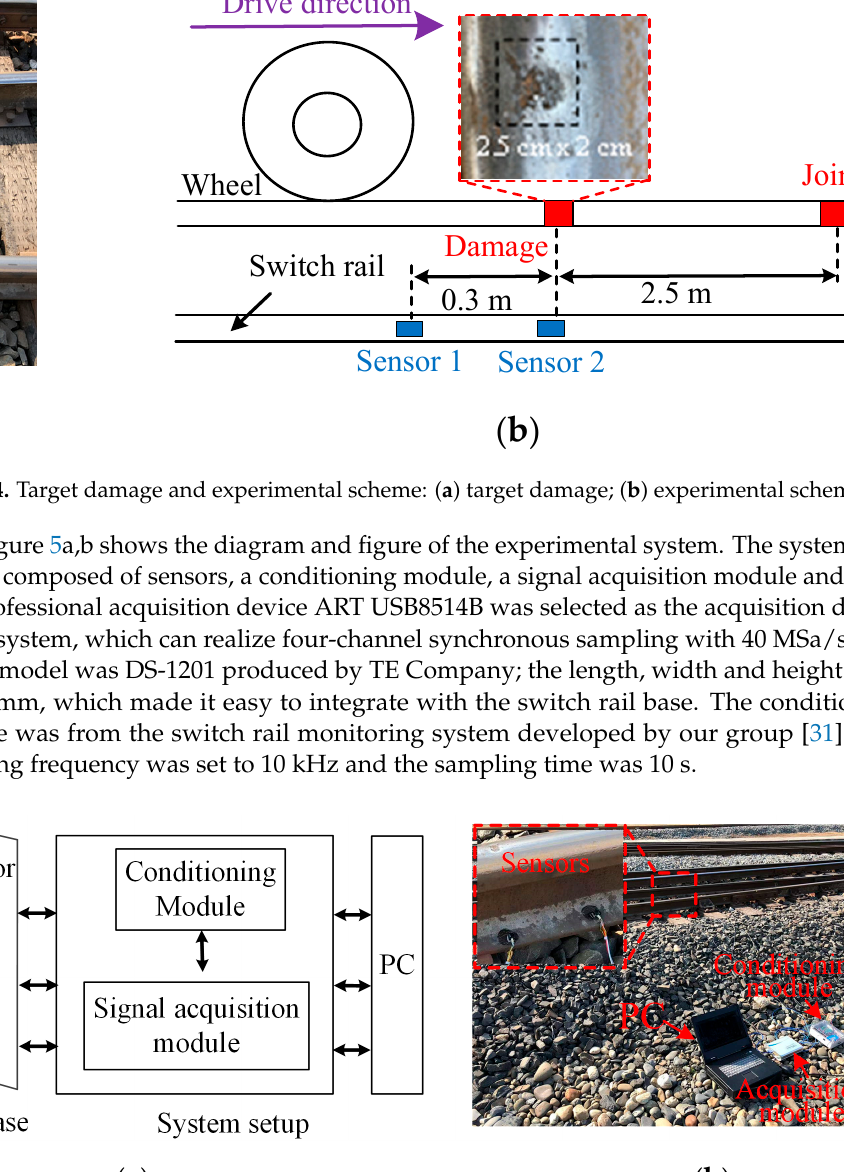
16 km/h (about 4.44 m/s) as an example, the time domain signals are shown in Figure 6.